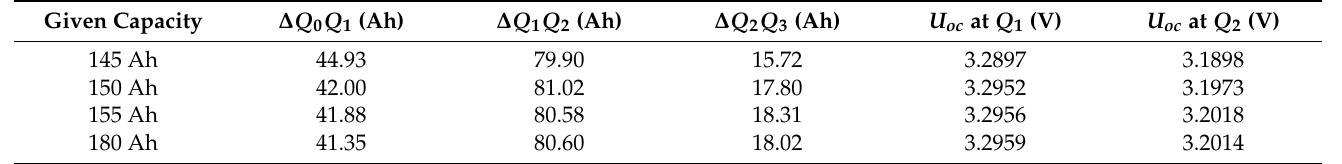
Table 3. Extracted features from the applied-DV curve based on different given battery